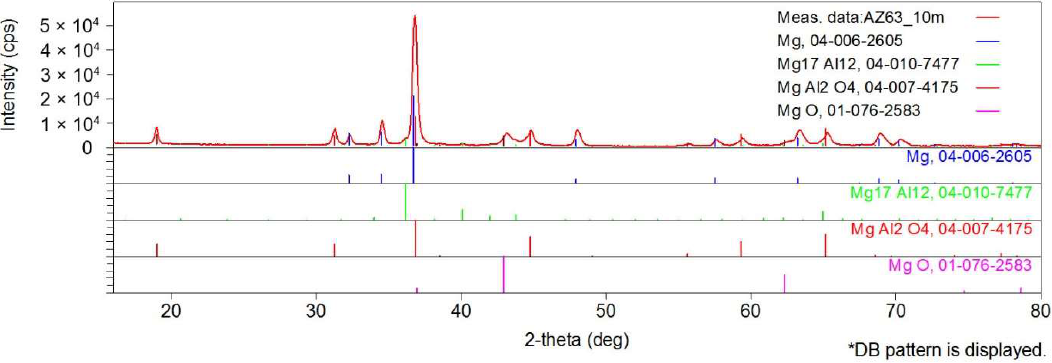
Figure A3. AZ63_10m sample—XRD qualitative phase analysis with displayed PDF cards peak bars.